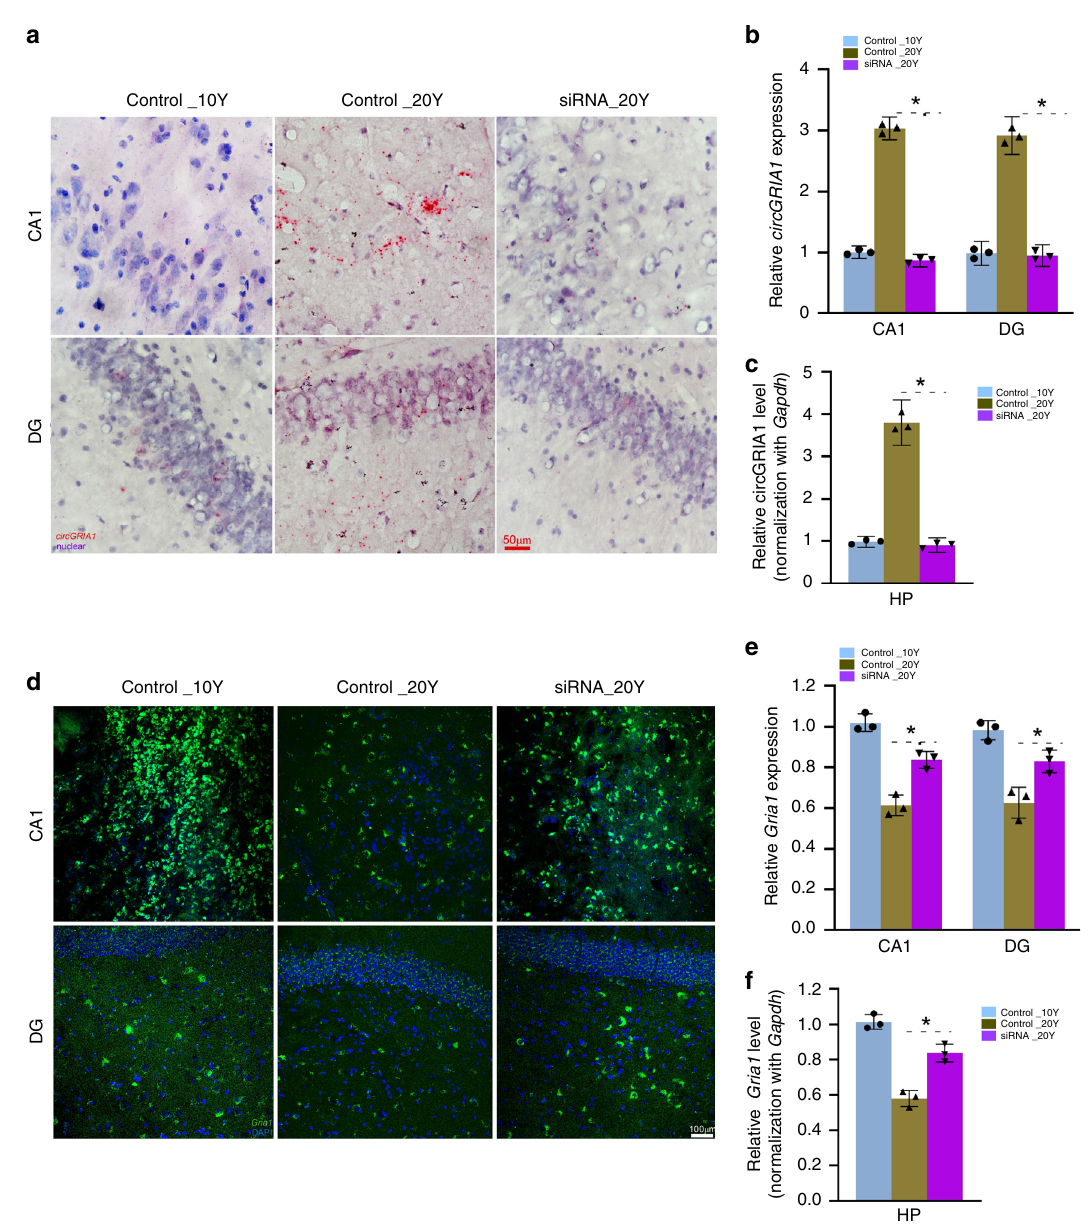
Fig. 5 Knockdown of circGRIA1 increases Gria1 expression. a BASEscope ISH showing circGRIA1 expression in macaque hippocampus. Ten-micron cryostat sections were performed BASEscope ISH (red dots with nuclei counterstaining by hematoxylin). Scale bar, 50 μ m. The images are representative of three independent experiments of each sample from 2 to 3 animals per age group. b Relative intensities of BASEscope ISH signals of circGRIA1 illustrated in ( a ) were quanti fi ed by use of Image J. Data are present as mean ± S.D. ( n = 35 – 45 cells per group; * p < 0.05, unpaired t- test). c RT-qPCR was performed for validation of circGRIA1 expression. Data are presented as mean ± S.D.; n = three independent experiment of each sample from 2 to 3 animals per age group; * p < 0.05, unpaired t- test. d RNAscope ISH showing Gria1 mRNA expression. Ten-micron cryostat sections were performed RNAscope ISH (green dots with nuclei counterstaining by DAPI). Scale bar, 100 μ m. The images are representative of three independent experiment of each sample from 2 to 3 animals per age group. e Relative intensities of RNAscope ISH signals of Gria1 illustrated in ( d ) were quanti fi ed by use of Image J. Data are present as mean ± S.D. ( n = 60 – 75 cells per group; * p < 0.05, unpaired t- test). f Total RNAs were extracted from postmortem frozen hippocampal tissues of 10- and 20- year-old female macaques with microinjection of viral particles containing siRNAs against circGRIA1 or siRNA-control into hippocampus of macaque brains as indicated. qPCR was performed for validation of Gria1 expression. Data are presented as mean ± S.D.; n = three independent experiments of each sample from 2 to 3 animals per age group; * p < 0.05, unpaired t- test, error bars denote S.D. Source data are provided as a Source Data fi